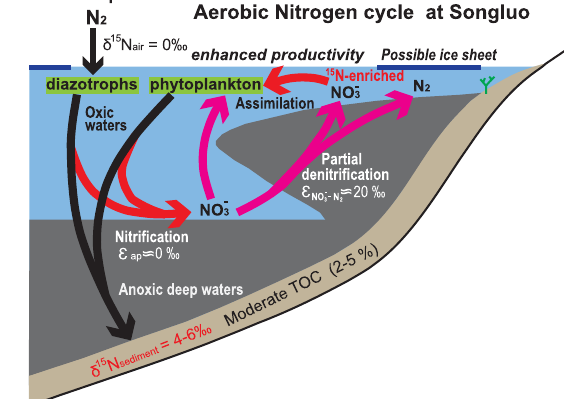
both low- and mid-latitude oceans (this study). Marine N biogeochemical cycle modelsaremodi fi edfromref. 40 .Alsonotetheexistenceofhabitableshallow-water environments for benthic phototrophic macroalgae. Dashed lines in the left panel bracket approximate latitudes where open waters may have existed in shallow oceans. TOC: total organic carbon; N: